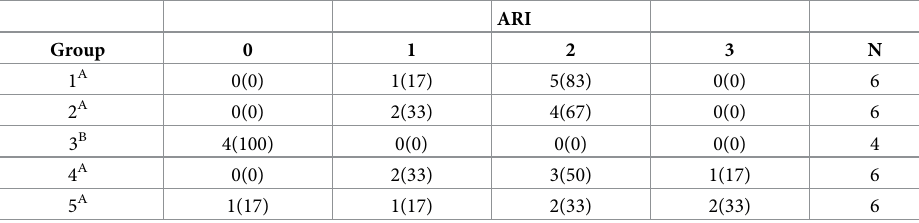
Table 4. Adhesive remnant index (ARI) scores on the teeth surface after debonding. ARI Group 0 1 2 3 N 1 A 0(0) 1(17) 5(83) 0(0) 2 A 0(0)